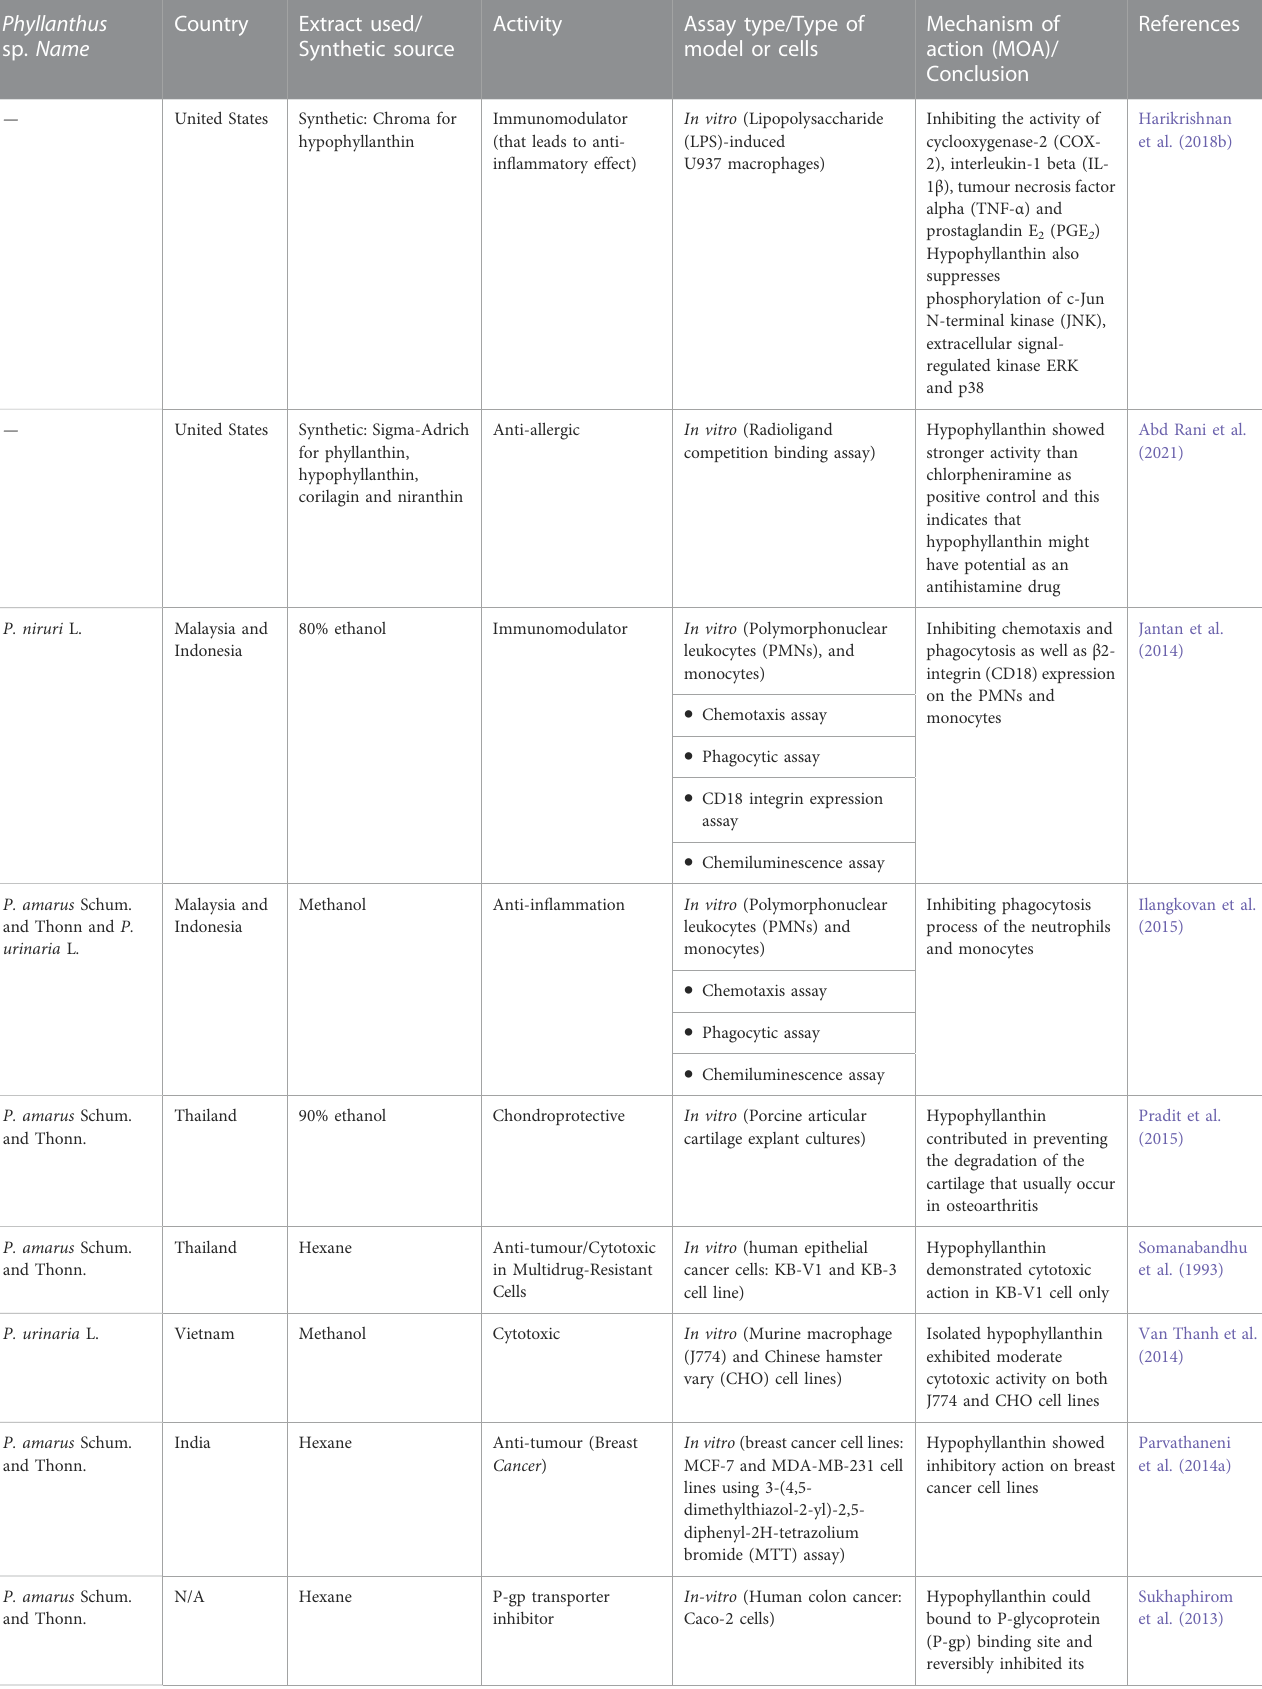
TABLE 2 In vitro pharmacological activities of hypophyllanthin and extracts of Phyllanthus species containing hypophyllanthin. Phyllanthus sp.